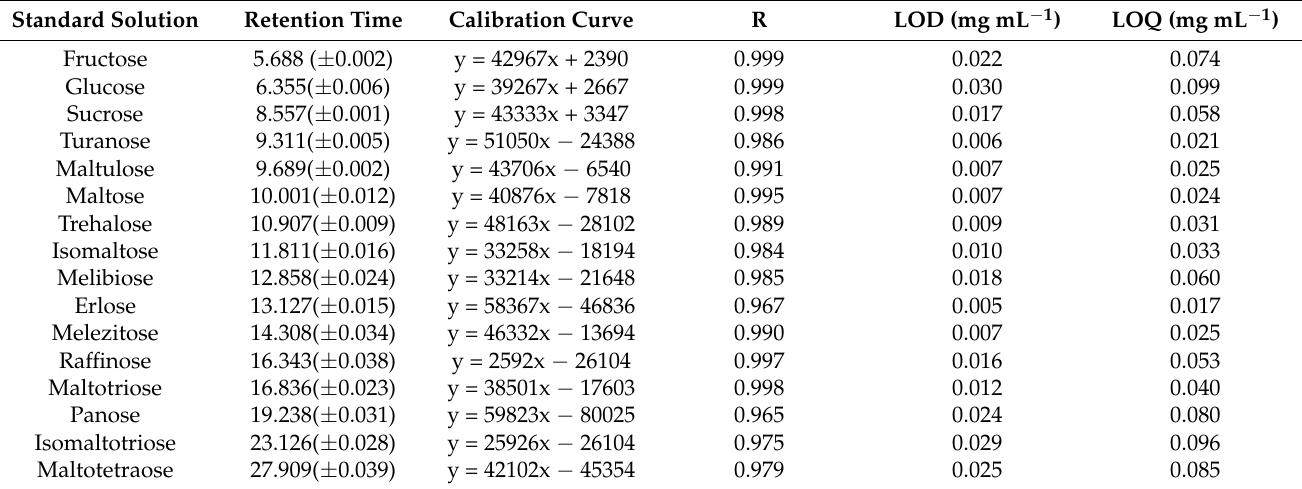
Table 2. Average retention time ( ± sd), equations, correlation coefficient, LOD (mg mL − 1 ) and LOQ (mg mL − 1 ) of the 16 studied